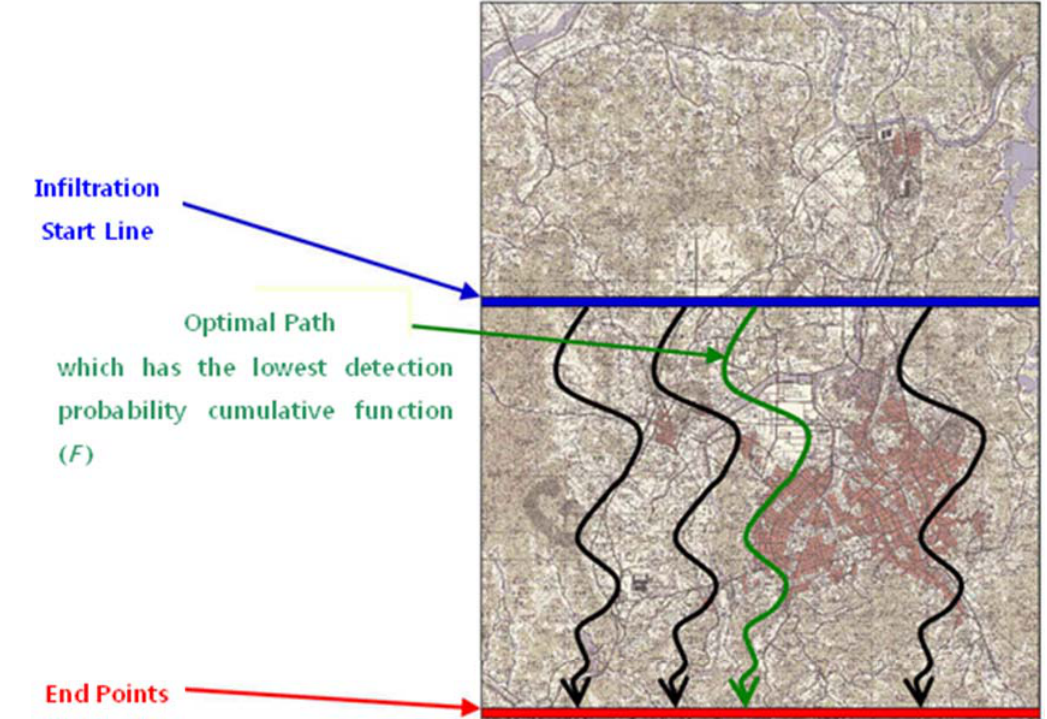
Figure 2. Imaginary scenario for optimal infiltration-route analysis (an imaginary MDL,